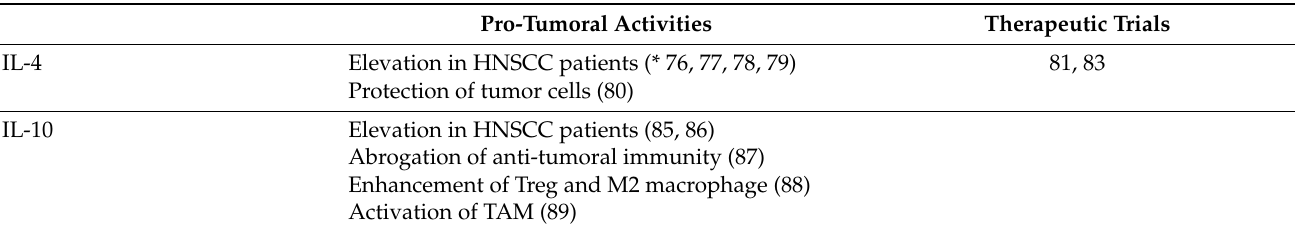
Table 3. Representative anti-inflammatory cytokines relevant to pro-tumoral and therapeutic trials for